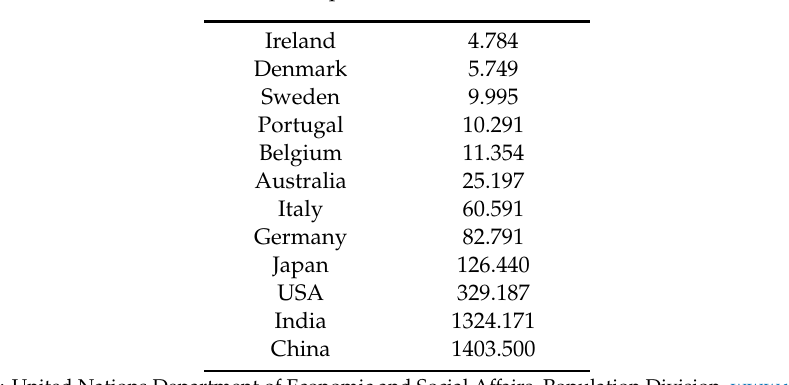
Table 2. Population in million,